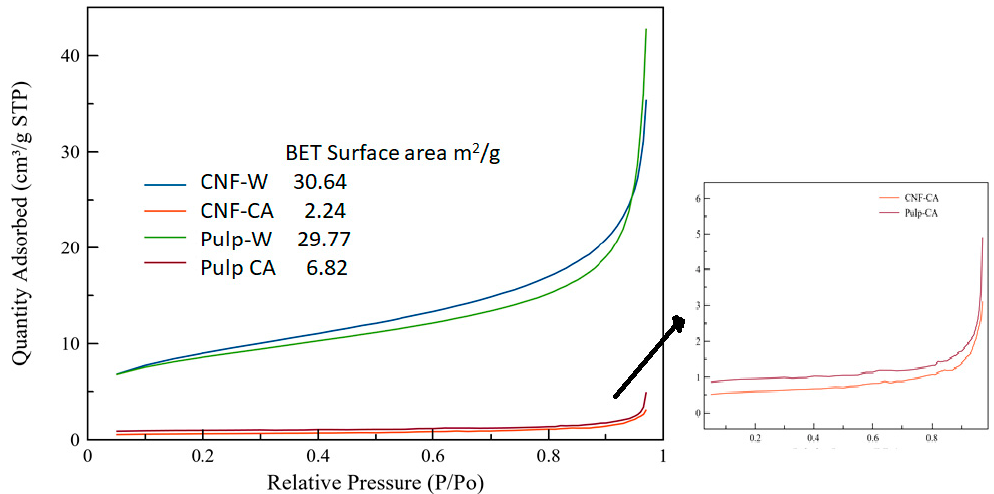
Figure 6. N 2 adsorption isotherms and BET (Brunauer, Emmett and Teller) surface area of